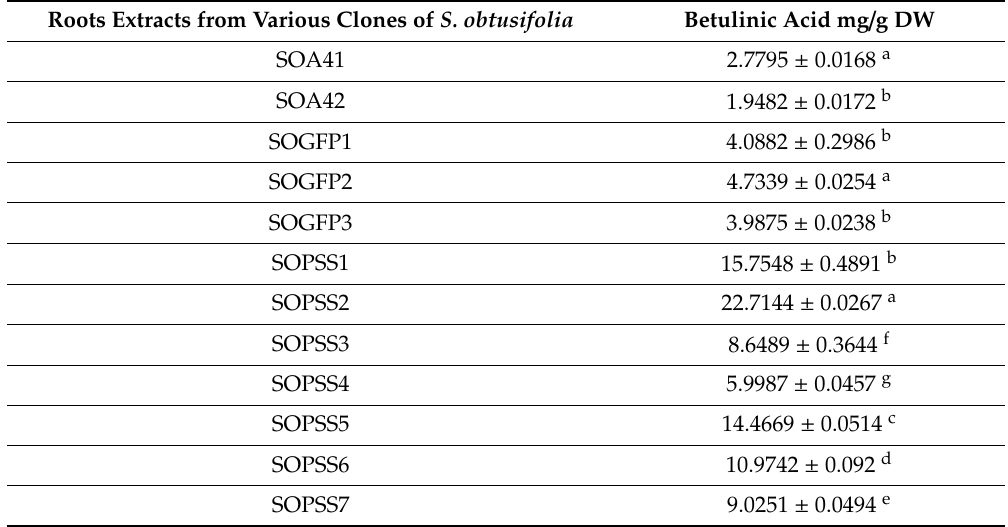
Table 2. Content of betulinic acid (mg / g DW) in extracts from di ff erent lines of S. obtusifolia hairy roots. Roots Extracts from Various Clones of S. obtusifolia